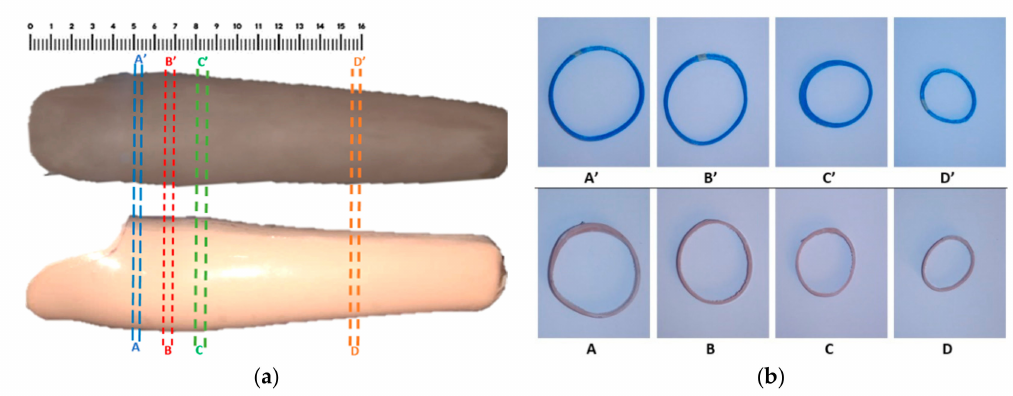
Figure 6. ( a ) The cutting location of the sockets: darker is 3D printed socket, lighter is casting socket; ( b ) pairs of cutting result: blue is 3D printed socket segments, brown is casting socket segments. Segment A was compared to segments A